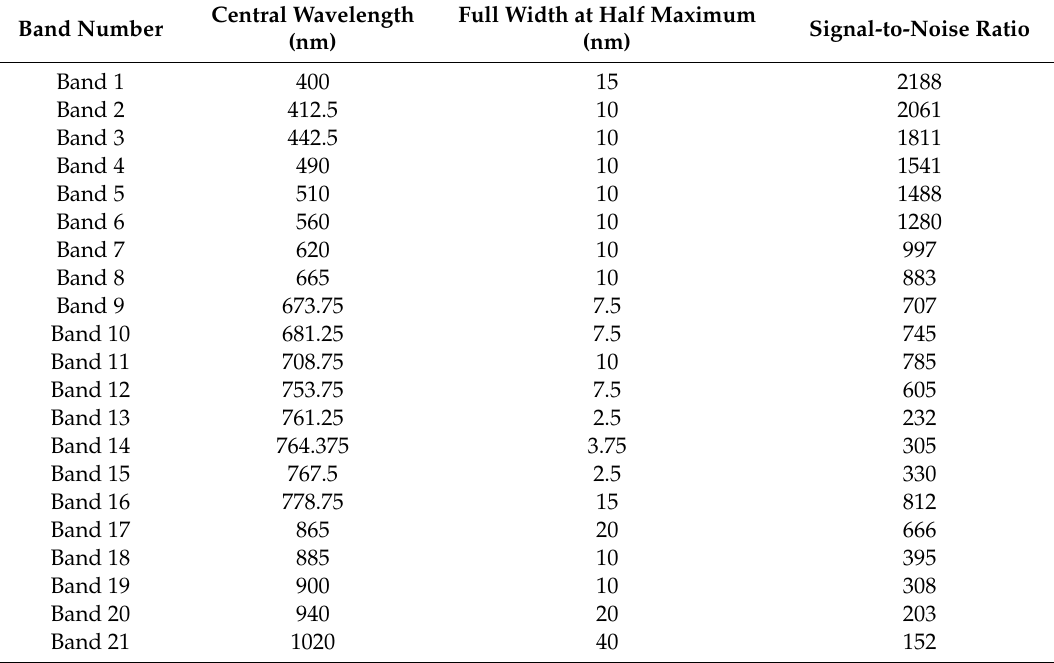
Table 1. OLCI band Table 1. OLCI band characteristics.